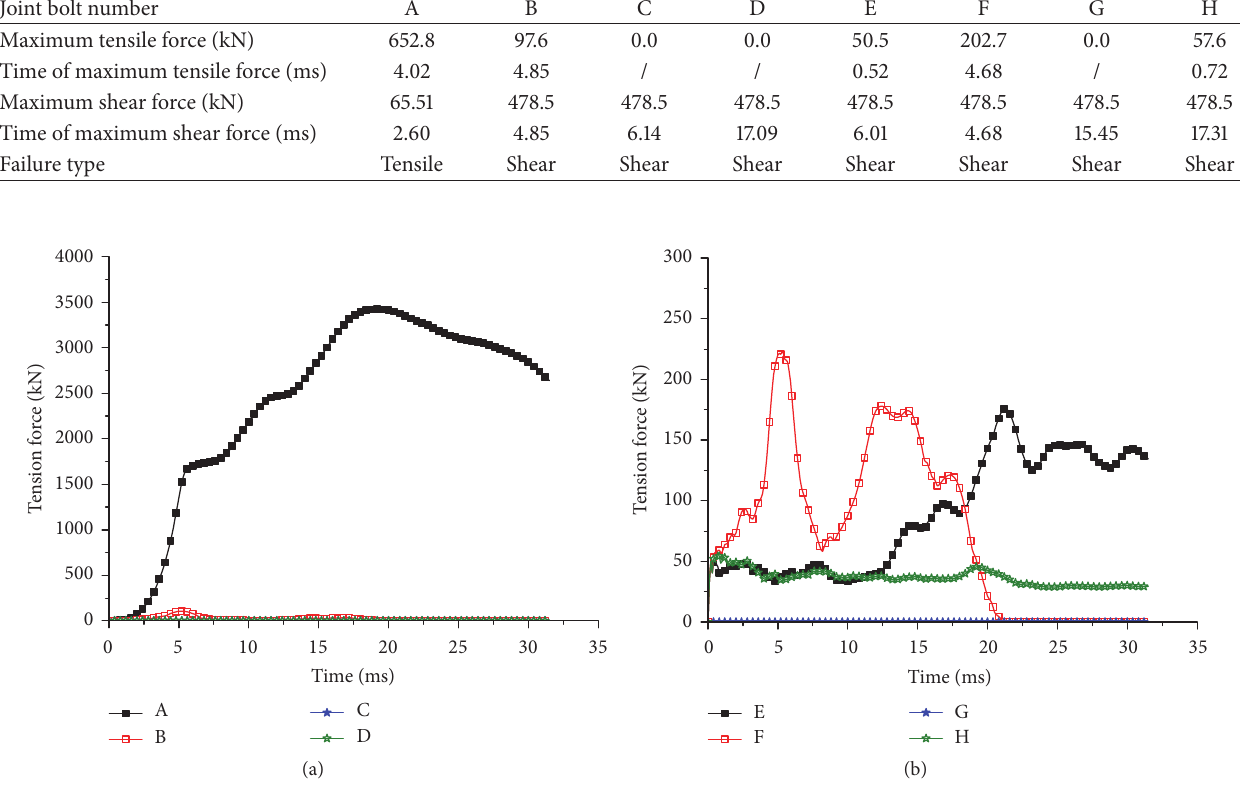
Figure 15: The tensile force time history curves for (a) bolts A, B, C, and D and (b) bolts E, F, G, and H in Model II.